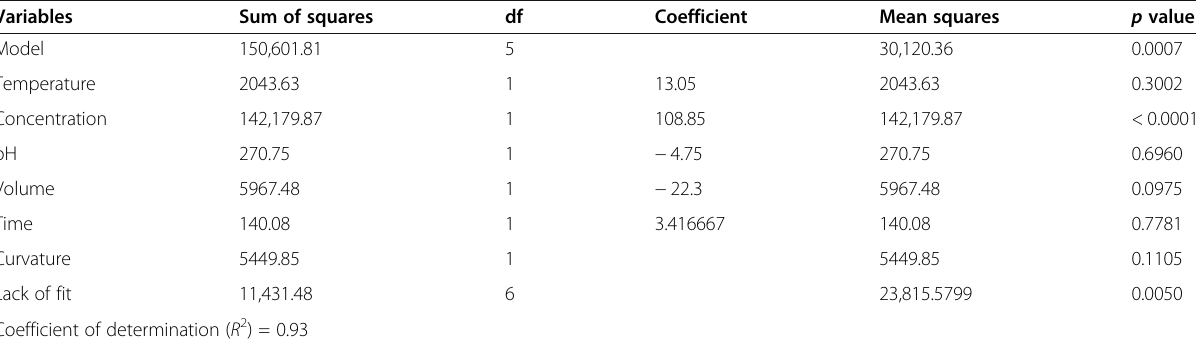
Table 3 Estimated effect, regression coefficient, and ANOVA of the Plackett-Burman matrix of different components for calcium chelation by demineralization process